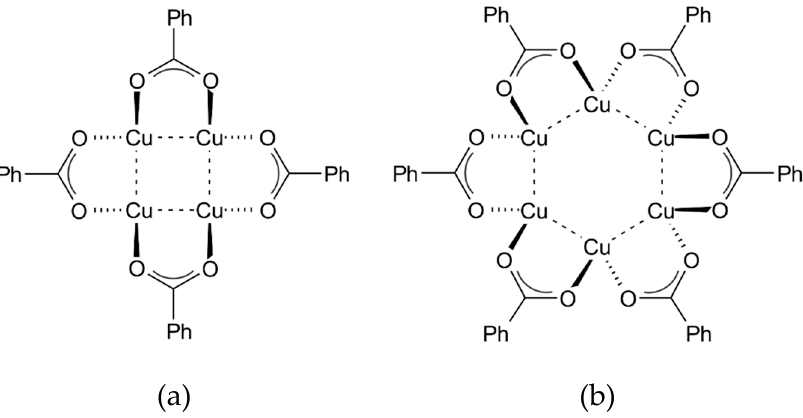
Scheme 1. Schematic representation of Cu 4 ( a ) and Cu 6 ( b ) complexes (Ph = phenyl).